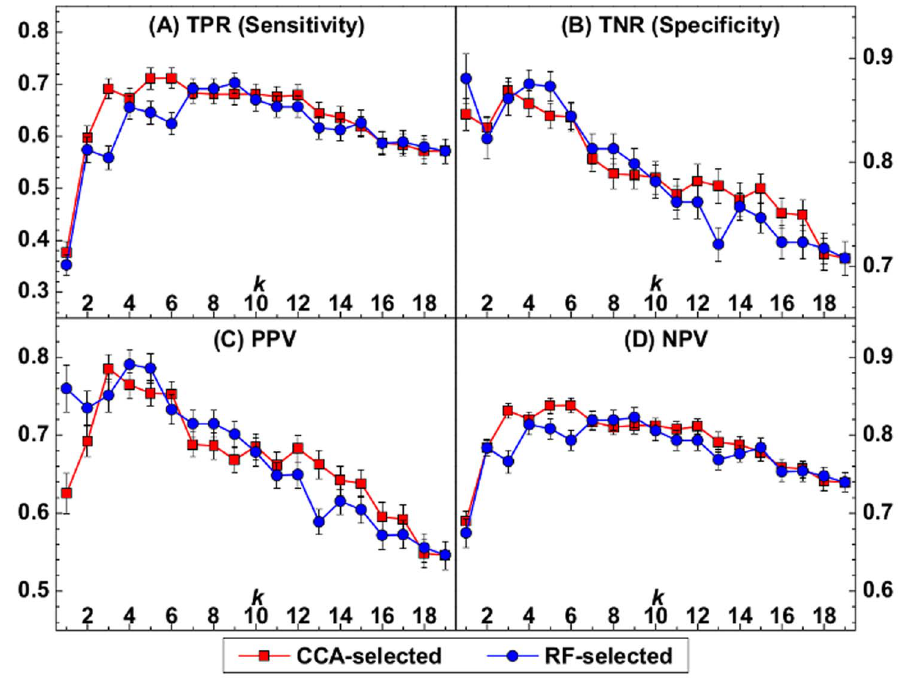
Figure 2. Prediction measures obtained from the Support Vector Machine (SVM) using the k -combinations selected by the Canonical Correlation Analysis (CCA) and Random Forests (RF) methods. The prediction measures (A) true positive rate (TPR), (B) true negative rate (TNR), (C) positive predictive value (PPV), and (D) negative predictive value (NPV) are shown for each step k . For each k , a SVM ensemble with bagging is constructed based on the CCA- and RF-selected subset of biomarkers. doi:10.1371/journal.pone.0108461.g002 show the statistical measures in Fig. 3(A). Overall, we find that Ang-2 and Ang-2/Ang-1 have comparable prediction perfor- mance (Fig. 3(A)). However, Ang-2/Ang-1 outperforms Ang-2 for PPV (0.76 for Ang-2/Ang-1, 0.63 for Ang-2), which suggests that